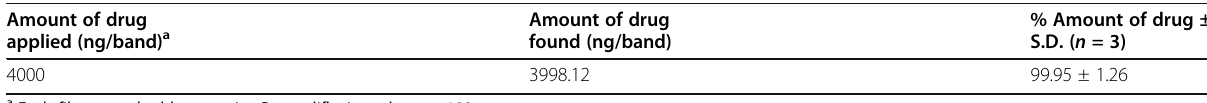
Amount of drug found